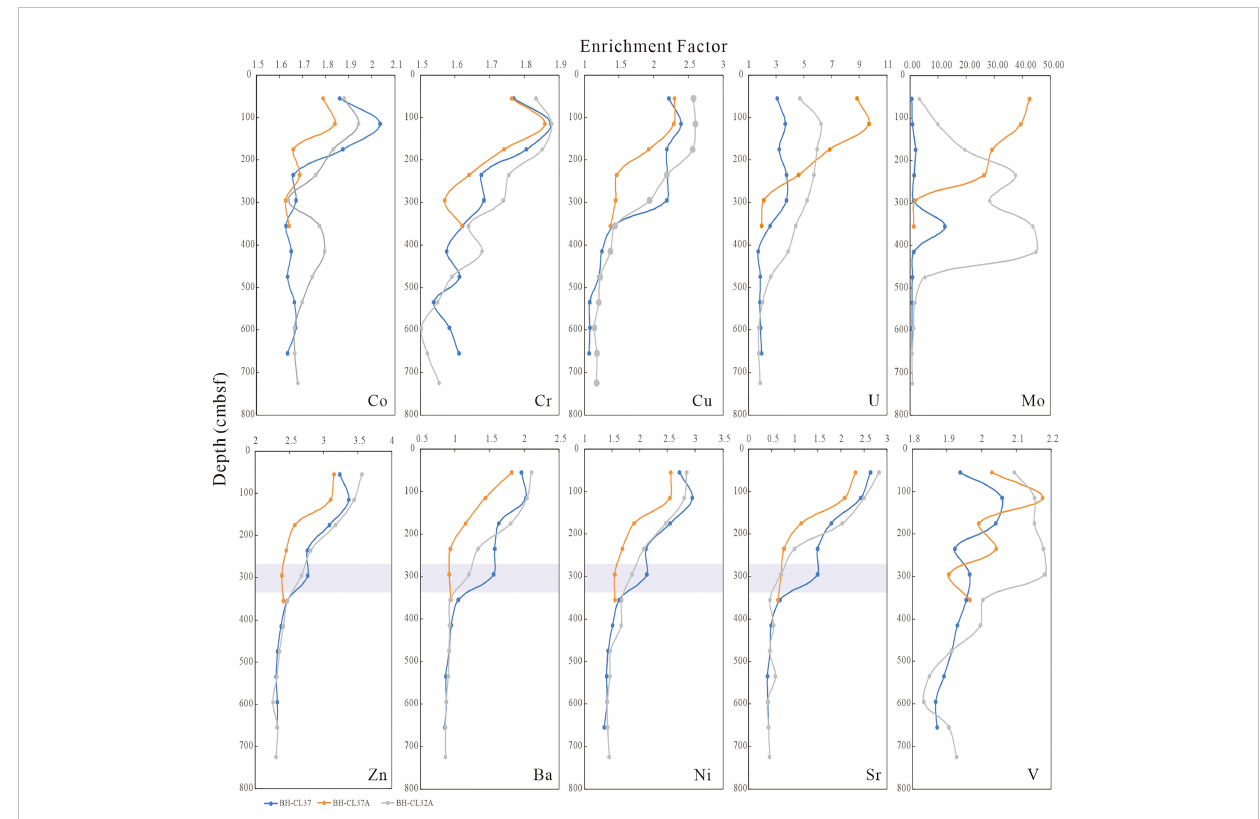
FIGURE 8 Depth pro fi les of trace element enrichment factors. The shadow area denotes a kink-type